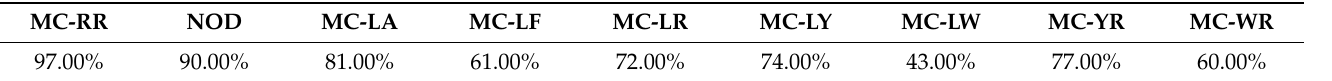
Table 4. Average recoveries for quality controls (QC) of eight microcystin congeners and nodularin obtained from 6 different days of sample